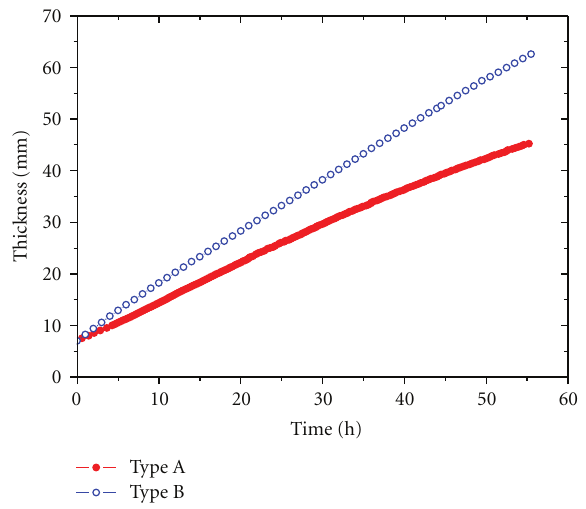
Figure 2: The deposition thickness change of silicon rod with deposition time.